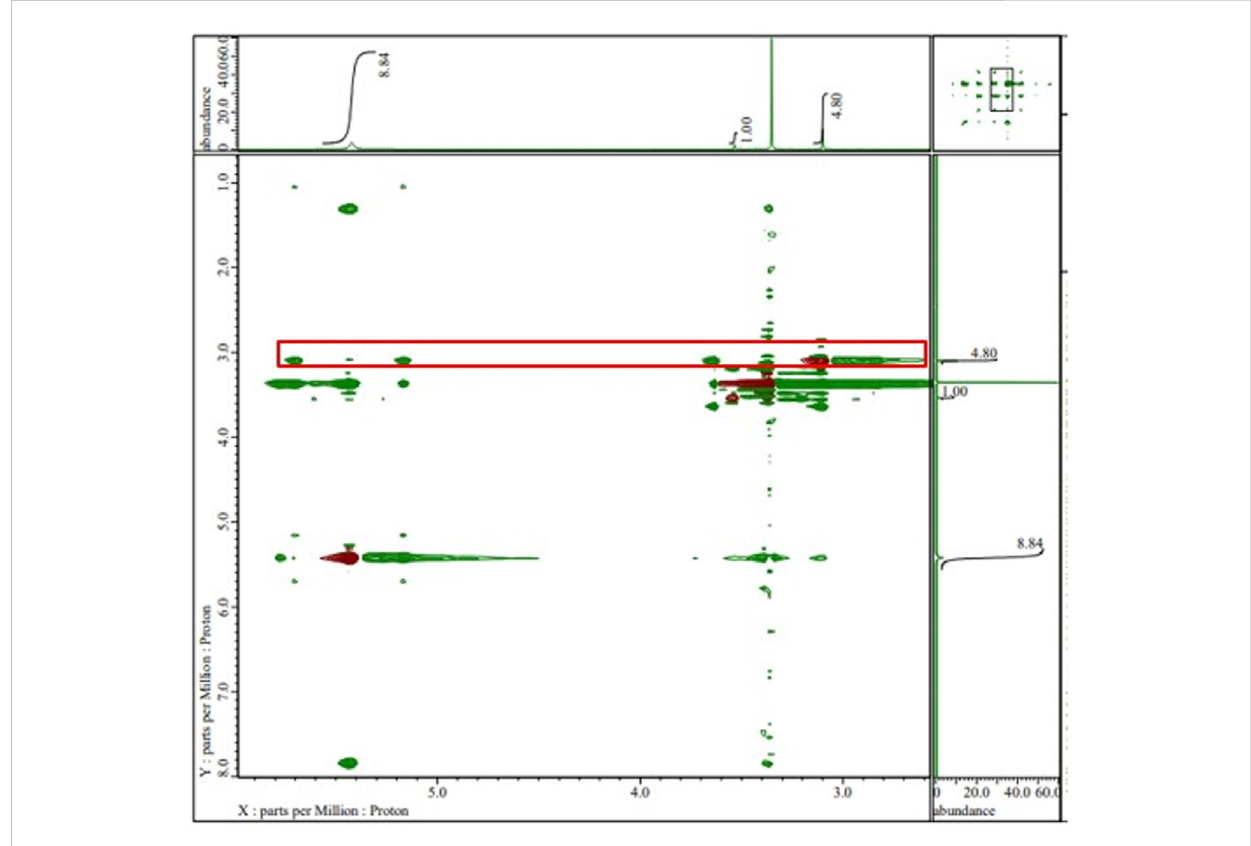
NOESY spectra of rosmarinic acid in betaine-urea at 298